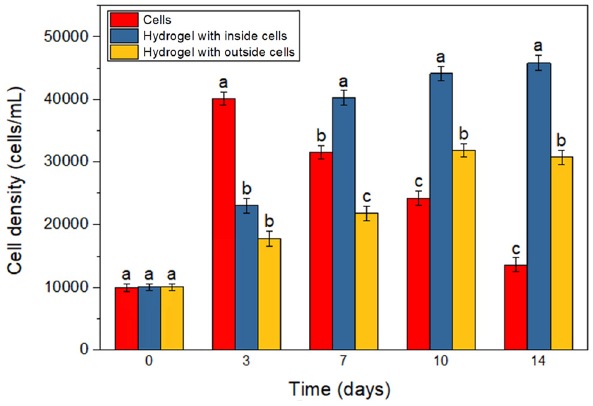
Figure 2: BALB/c 3T3 proliferation starting inside or outside the oxi - HA/ADH hydrogel during cultivation for 14 days. Data are reported as mean ± SD for experiments in triplicate. Mean values of the same group of days with the same letter indicate that there is no signif - icant di ff erence ( p < 0.05 ) by the Tukey